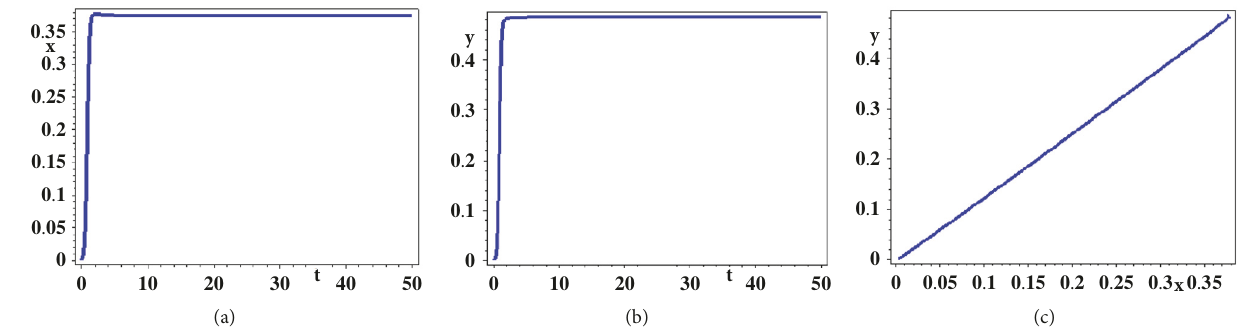
Figure 3: Time series and phase portrait of the globally asymptotical stability of the positive equilibrium (𝑥 ∗ ,𝑦 ∗ ) with the parameters 𝐴 = 12, 𝑞 = 0.4,𝐵 = 3.5.